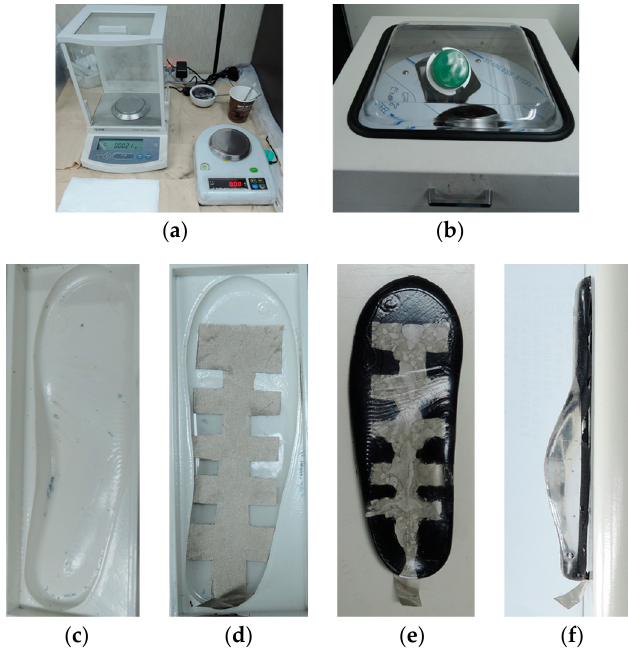
Figure 4. Processing tools and sequential insole shape: ( a ) weighing scale, ( b ) planetary centrifugal mixer (PCM) blending machine, ( c ) insole mold, ( d ) upper poly ‐ dimethyl ‐ siloxane (PDMS) layer with top electrode, ( e ) final insole top view, ( f ) final insole side view.